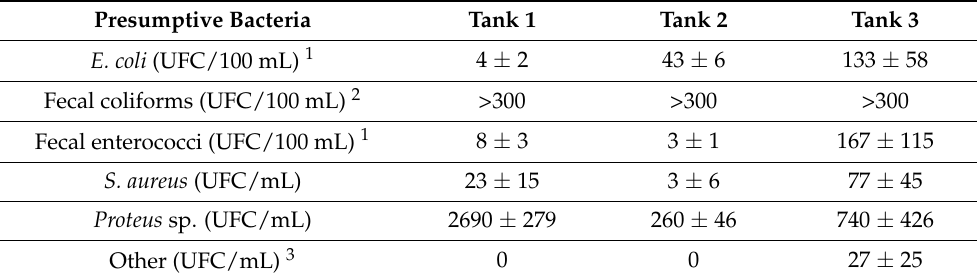
Table 1. Presumptive bacteria counting, at 37 ◦ C, by membrane filtration (UFC/100 mL) on the differential media Slanetz and Chromo media, or by spread techniques (UFC/100 mL) on C.L.E.D. medium. Mean values (n = 3) ± standard